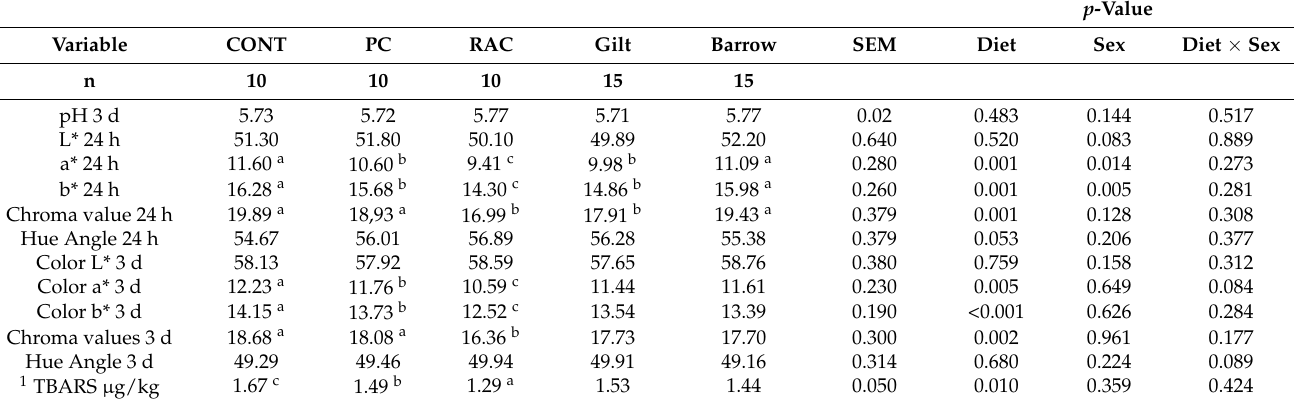
Table 5. Effects of different treatments on the shelf life of meat (Longissimus dorsi) stored after 3 days.